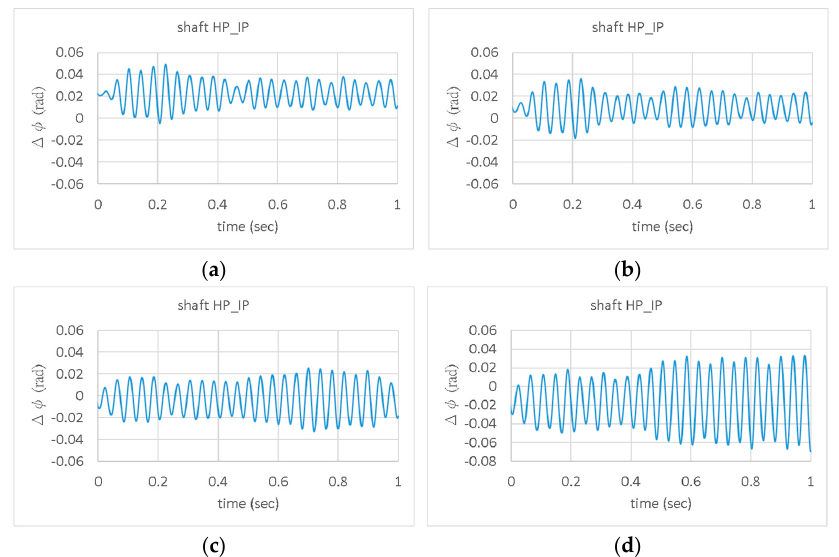
Figure 16. Torsional vibrations for different penetration rates of PMSG wind power. ( a ) 12.5%. ( b ) 37.5%. ( c ) 62.5%. ( d ) 87.5%.